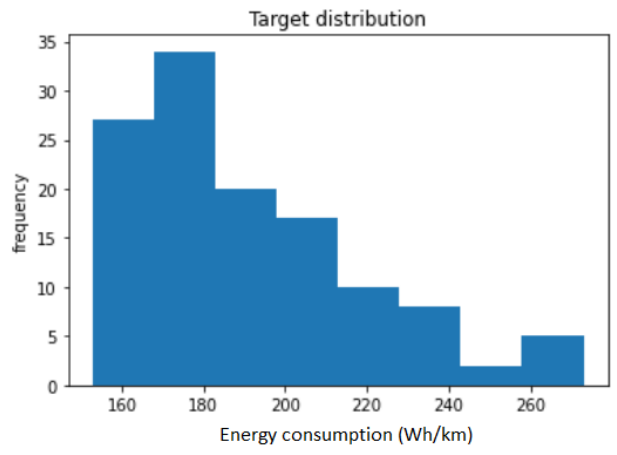
Figure 5. Distribution of the data analyzed for the energy consumption parameter.